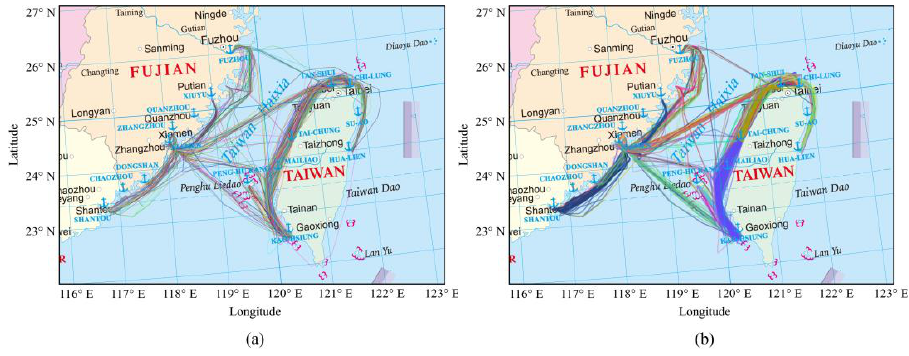
Figure 8. Spatial distribution of ship trajectories and trajectory clustering results between ports in the study area. ( a ) shows the ship trajectories extracted based on AIS data. ( b ) shows the clustering result of ship trajectories, where trajectories with the same color belong to the same clustering class.